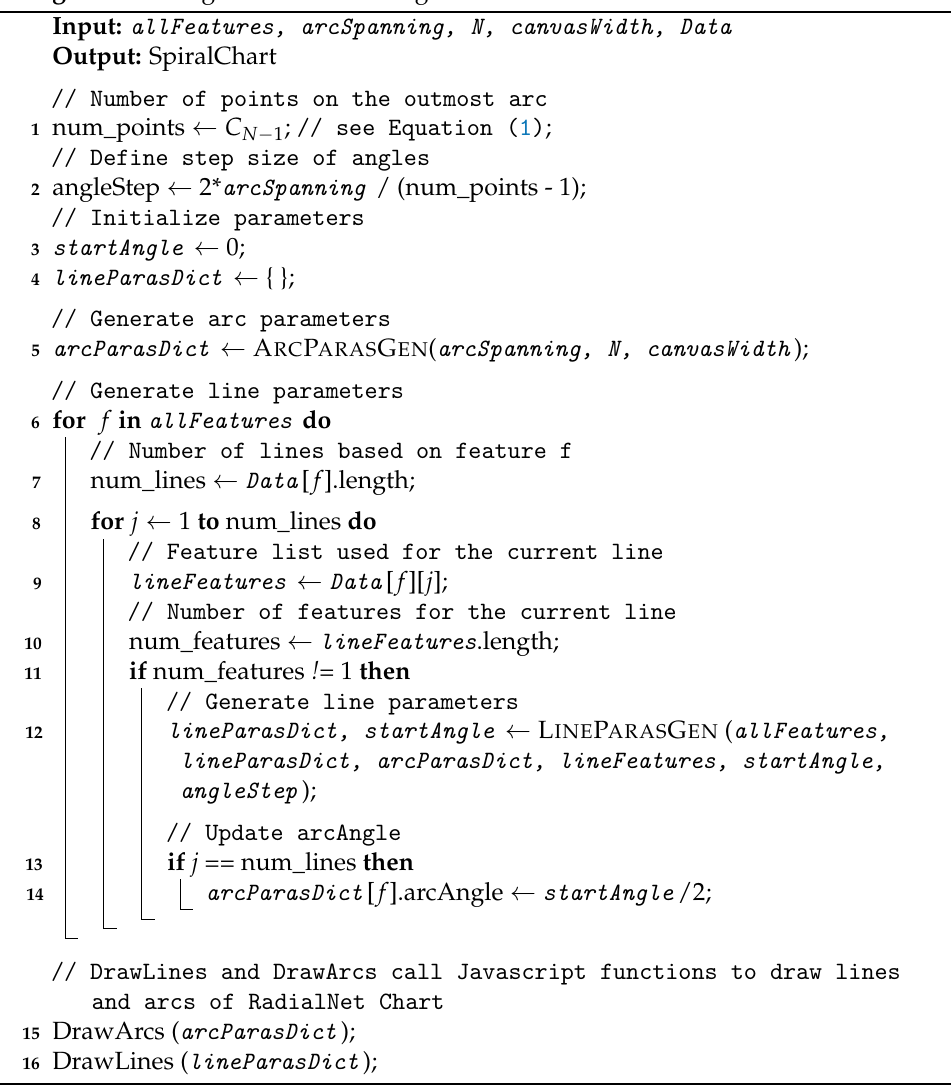
Algorithm 3: Algorithm for drawing